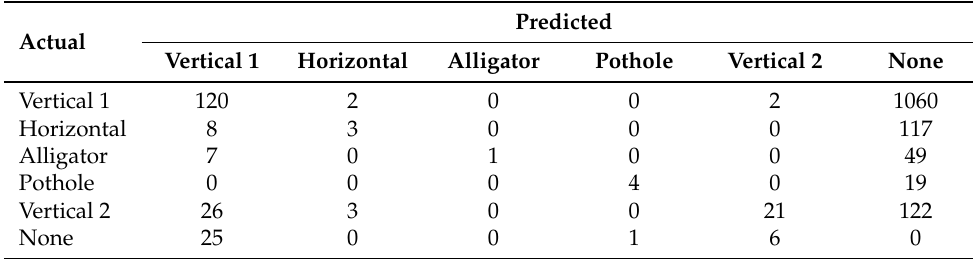
Table 13. Confusion matrix of Model 7.